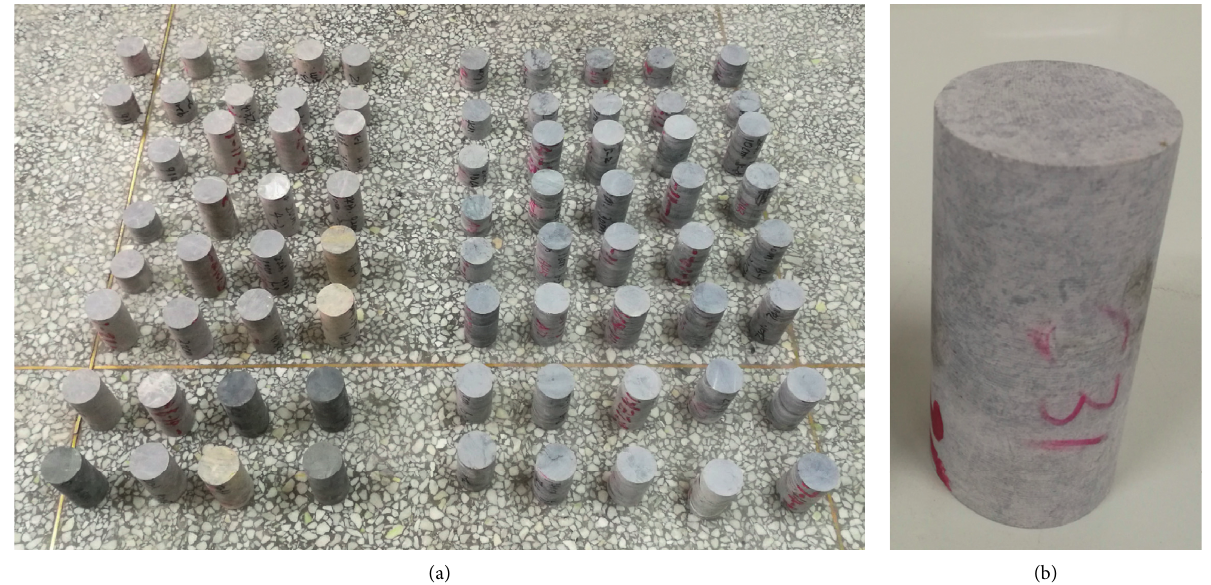
Figure 2: Prepared rock specimens. (a) Standard specimens. (b) Typical Yunnan